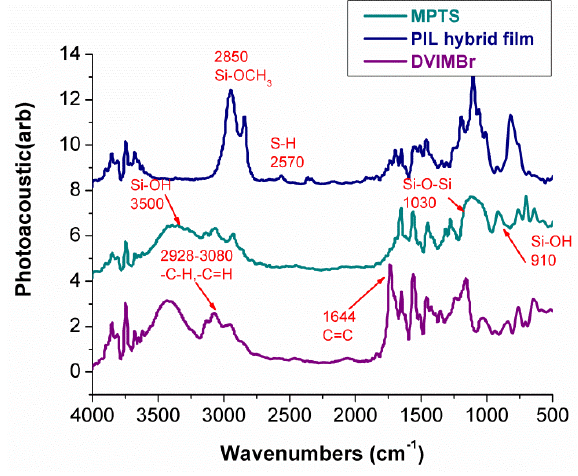
Figure 2. FTIR spectra of MPTS, DVIMBr, and PIL hybrid film.